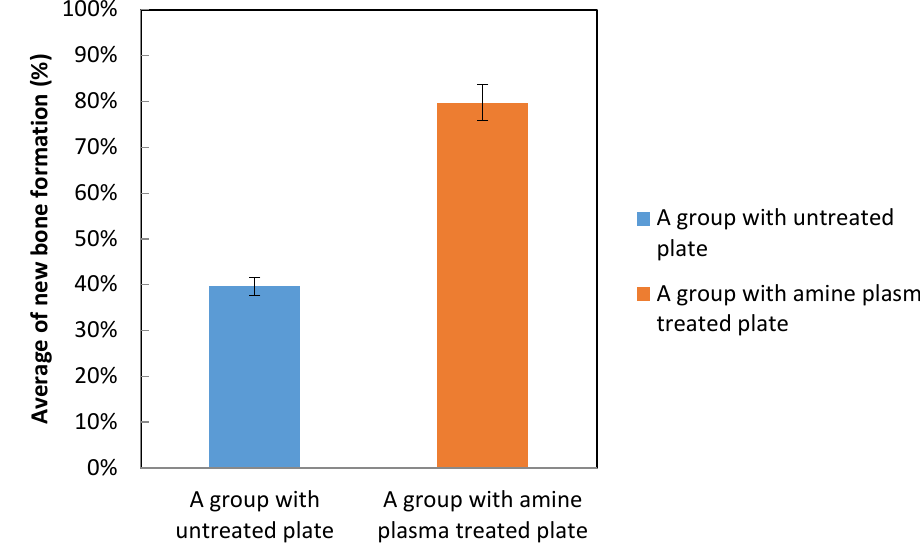
Figure 13. Comparison of the average percentage of new bone formation for each specimen in the animal experiment.